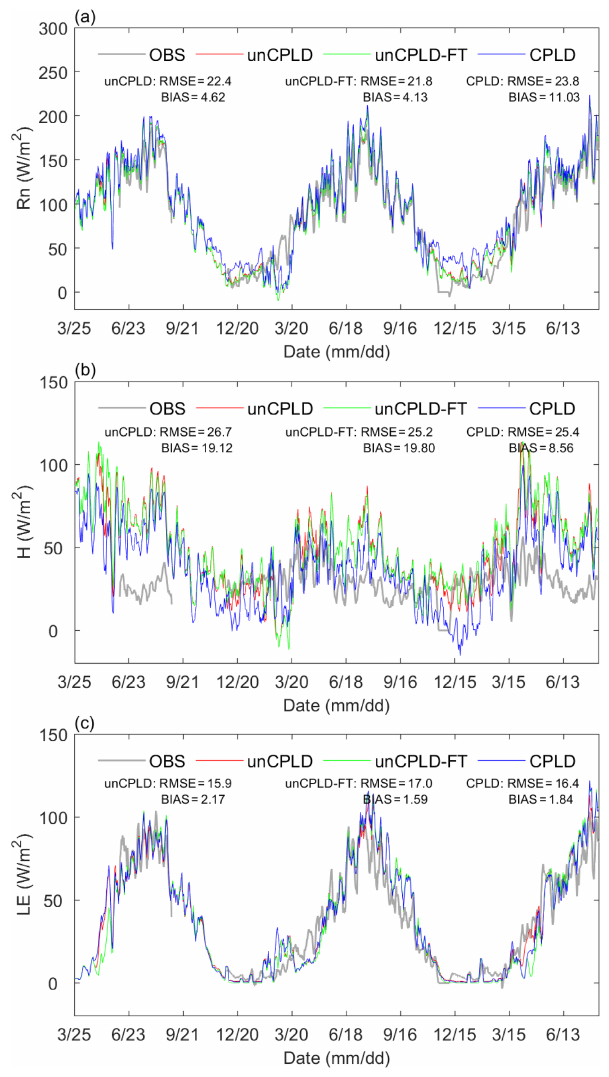
Figure 4. Comparison of observed and simulated 5d moving aver- age dynamics of net radiation (Rn), latent heat flux (LE), and sen- sible heat flux ( H ) using the original (uncoupled) T&C (unCPLD), T&C with consideration of the FT process (unCPLD-FT), and cou- pled T&C and STEMMUS (CPLD)